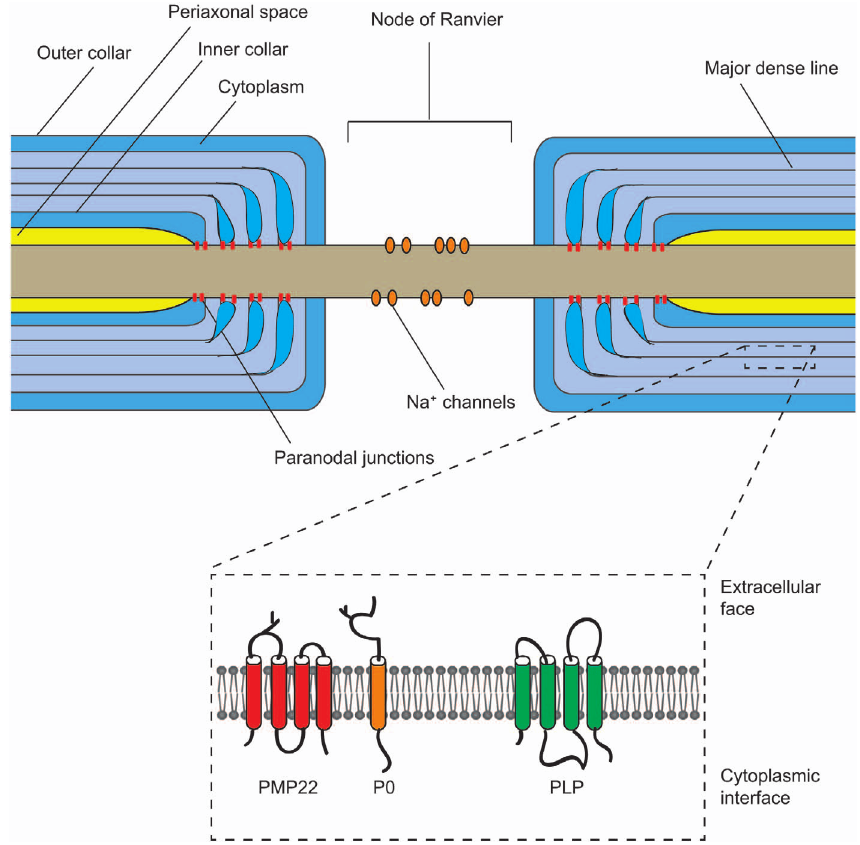
Figure 1 Compact myelin sheaths are required for nervous system function. Schwann cells and oligodendrocytes wrap membranous extensions around axons to form compact myelin sheaths. Each Schwann cell forms a distinct internode, whereas oligodendrocytes myelinate multiple internodes. Voltage-gated Na q channels are clustered at the nodes of Ranvier, areas of unmyelinated axons between internodes. Paranodal junctions are found adjacent to the nodes of Ranvier to provide a diffusion barrier. Compact myelin sheaths are maintained through adhesive myelin proteins expressed at the cell surface, such as peripheral myelin protein 22 (PMP22) and myelin protein zero (P0) of the peripheral nervous system (PNS) and proteolipid protein (PLP) of the central nervous system